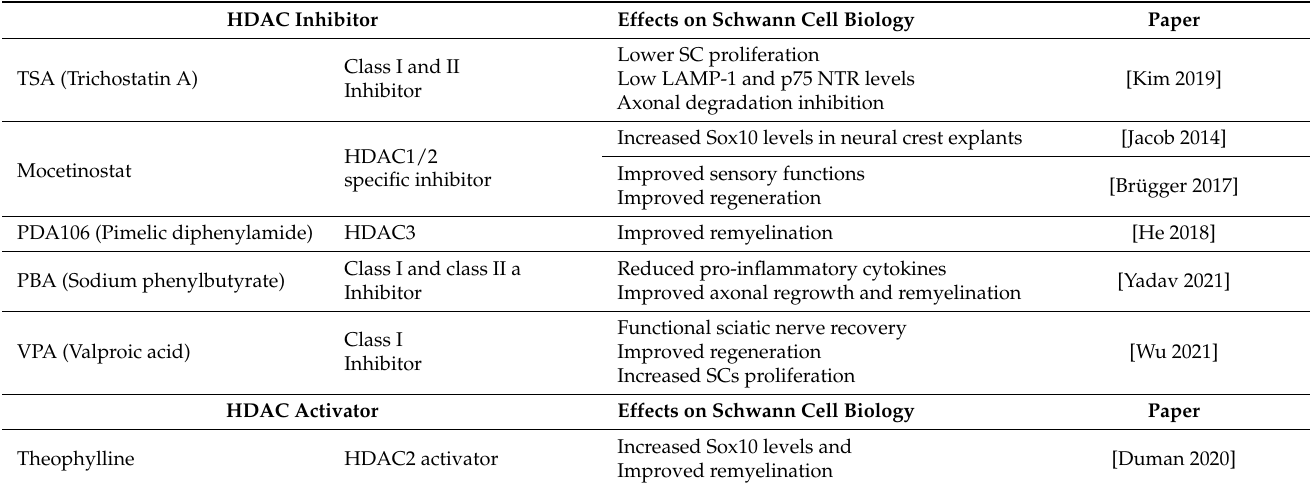
Table 2. HDACs inhibitor or activator used in in vivo Schwann cell (SC) or peripheral nervous system (PNS) studies. (Note: Mocetinostat is also an HDAC3 and HDAC11 inhibitor. Theophylline is also an HDAC1